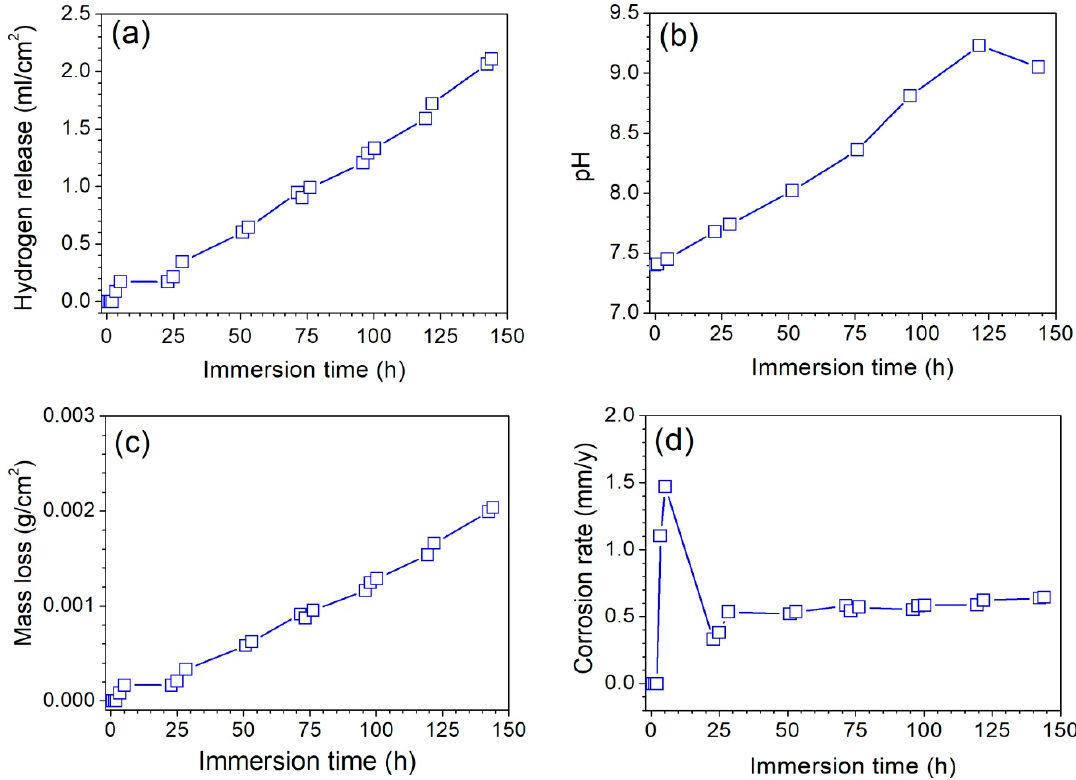
Figure 5. Results from hydrogen release tests of EZ51-IM350 alloy immersed in PBS (phosphate buffered saline) solution. ( a ) Hydrogen release, ( b ) pH evolution, ( c ) mass loss, and ( d ) corrosion rate.